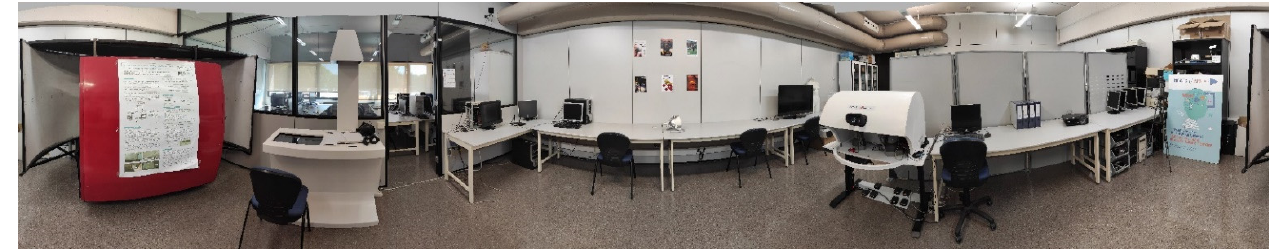
Figure 3. Three hundred and sixty degree image of the environment in which the experimental study was carried out.